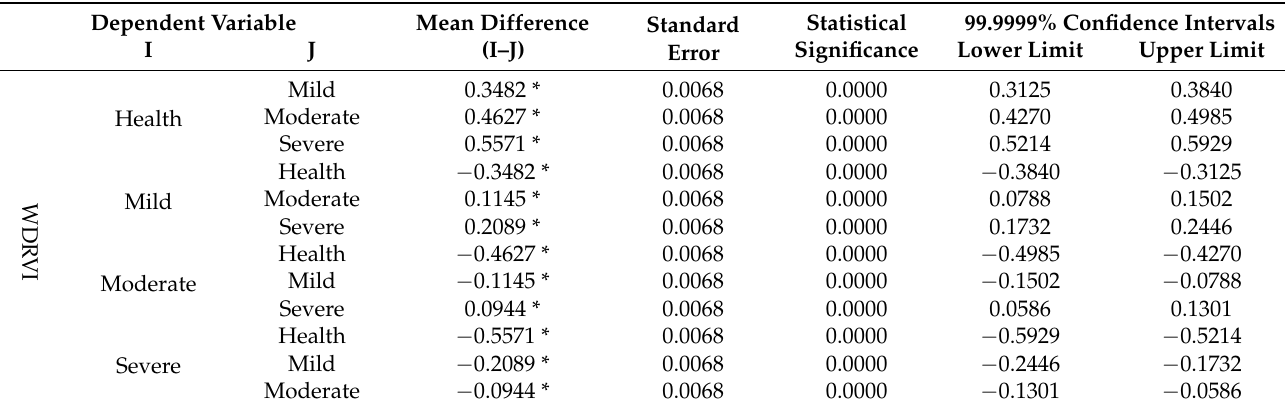
Figure A1. Schematic diagram of the convolutional neural network model. Table A1. Features’ honestly significant difference.